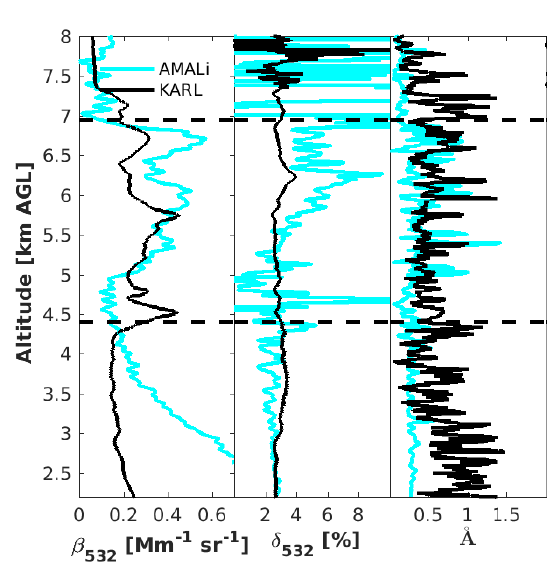
Figure 2: Vertically resolved optical properties as inverted from AMALi and KARL.